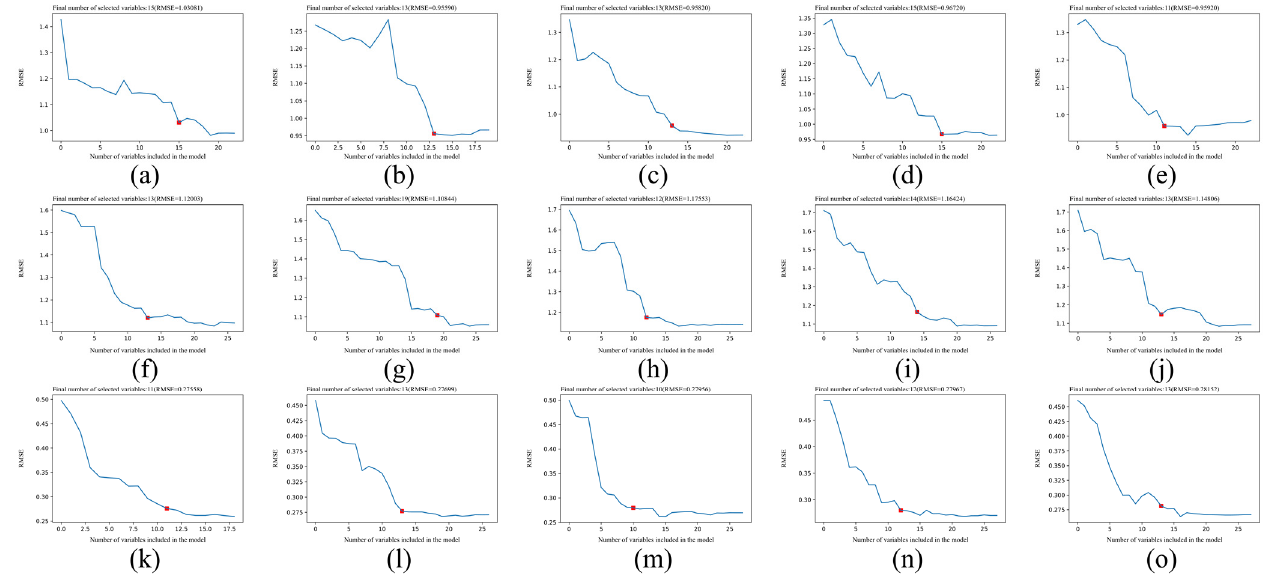
Figure 4. SPA treatment obtained RMSE iterative descent curve. ( a ) DPC-OS-SPA; ( b ) DPC-CWT-